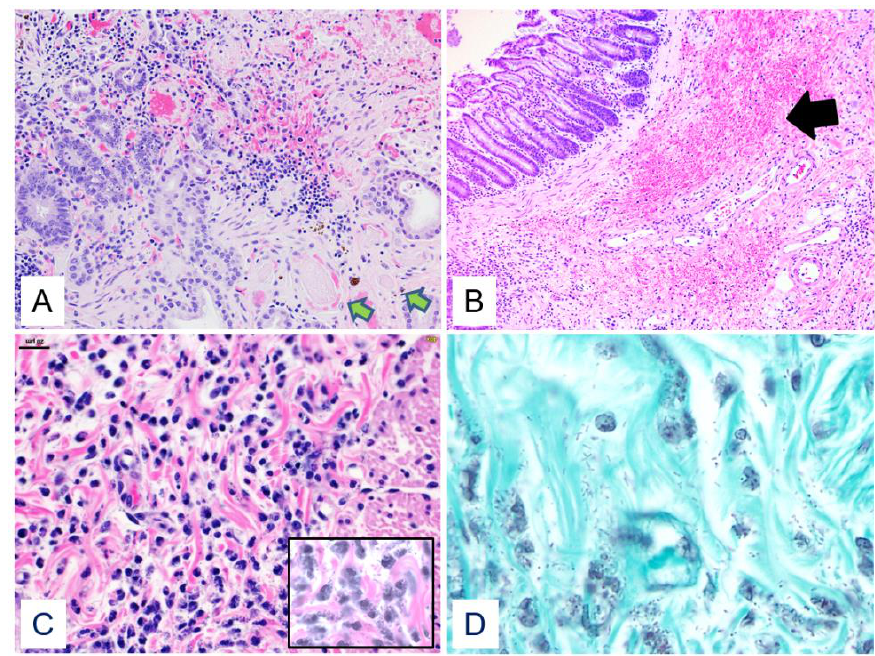
Figure 4. ( A – D ) A . Duodenum, macaque, HE, 200 × . In an area of mucosal necrosis, there are numerous intravascular fibrin thrombi in submucosal blood vessels (green arrows). B . Distal colon, macaque, HE, 40 × . There is focally extensive hemorrhage and edema in the submucosa with an inflammatory infiltrate (arrow). C . Colon, submucosa, macaque, HE, 400 × . High power magnification of the submucosa from C shows bacilli visible on HE staining that are surrounded by neutrophils and occasionally within the cytoplasm (inset, 600 × ). D . Colon, submucosal connective tissue, macaque,